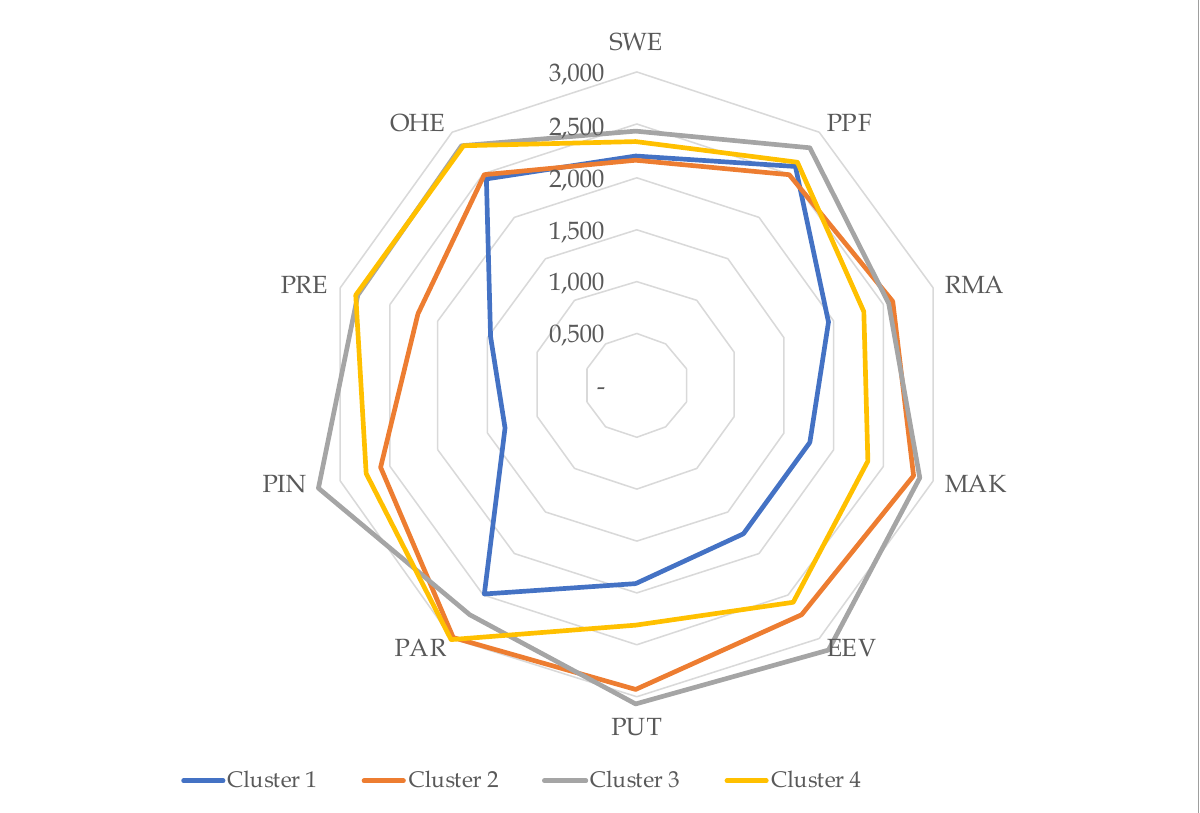
FIGURE6 Radar charts according to the average value of the dimension for each